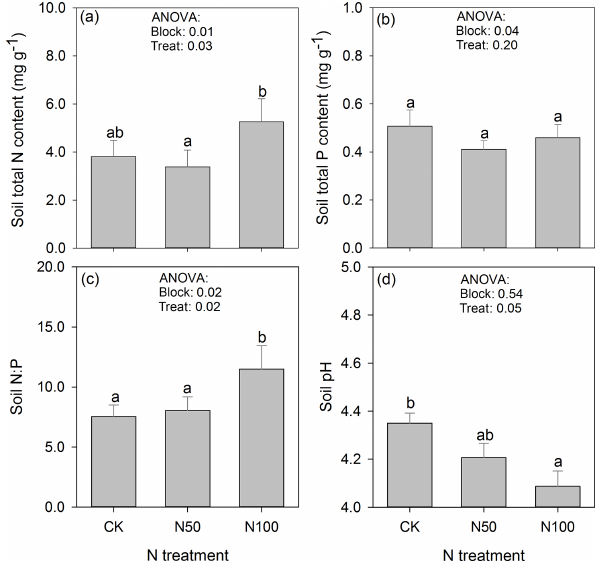
Figure 1. Effects of N fertilization on soil nutrient content, N:P ratio, and pH (mean ± SE, n = 3) at the soil depth of 0–10cm. (a) Total N content per gram soil, (b) total P content per gram soil, (c) N:P ratio and (d) soil pH. Numbers in these figures indicate the results of ANOVA.